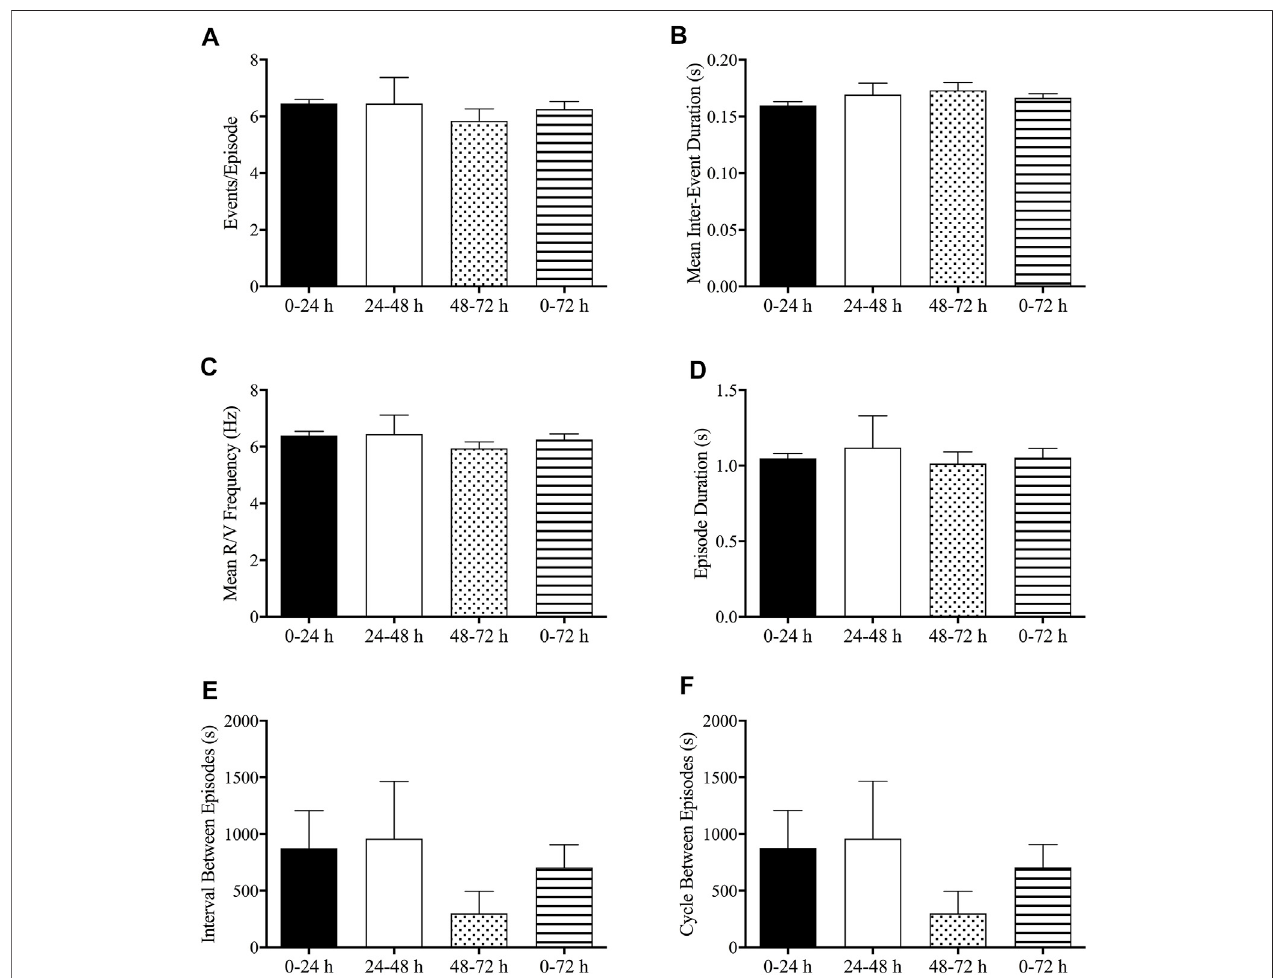
FIGURE7| Analysisofemeticdatausingburstanalysis. (A) Eventsperepisode/burst; (B) meaninter-eventduration; (C) meanretch/vomitfrequency; (D) episode durations; (E) interval between episodes; (F) cycles between episodes. The results are presented means ± standard errors of the mean for n (cid:1) 7 animals.